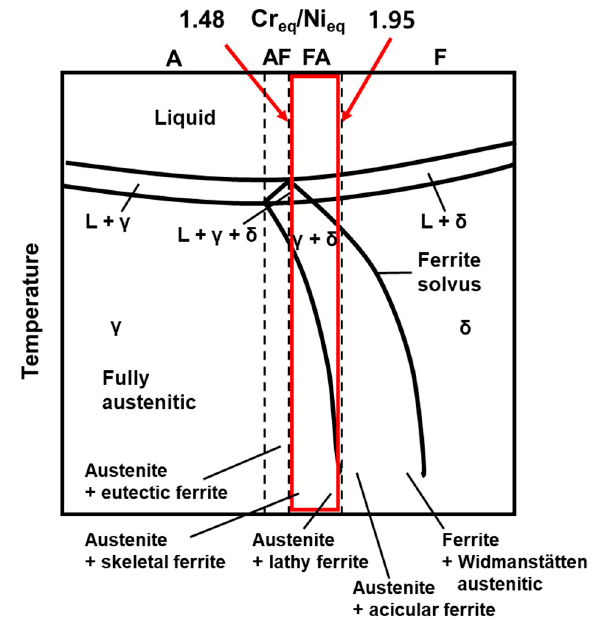
Figure 6. Relationship between the solidification type and the pseudo-binary phase diagram for austenitic stainless steel [21].